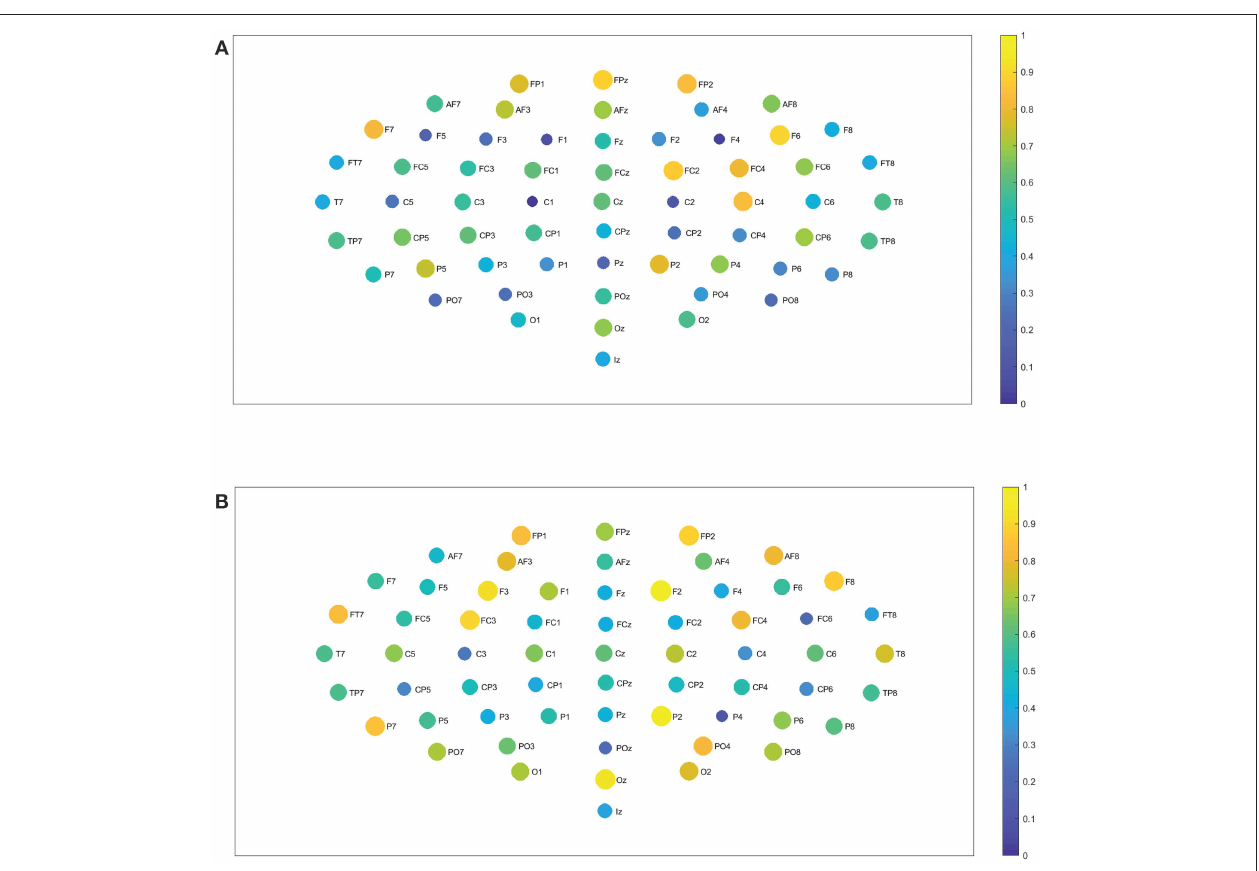
FIGURE 8 | Closeness centrality. (A) Shows the node closeness centrality considering 109 subjects when performing the visuomotor task for the 62-channels EEG considering the oscillation band alpha 1. (B) Is the same as (A) but considering the imagined task. We consider D = 6 and τ = 1. Alpha 1 oscillation band corresponds to [8,10) Hz